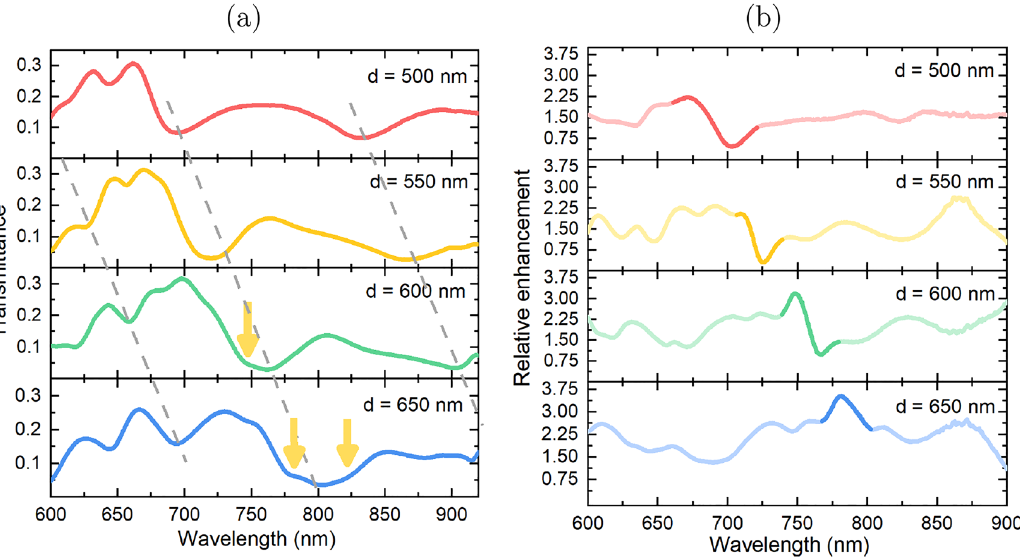
Figure 3: The transmittance (a) and the relative enhancement of the Faraday rotation (b) in the nanocylinder arrays with different nanocylinder diameters (see the legends). In (b) the spectral range in the vicinity of EH